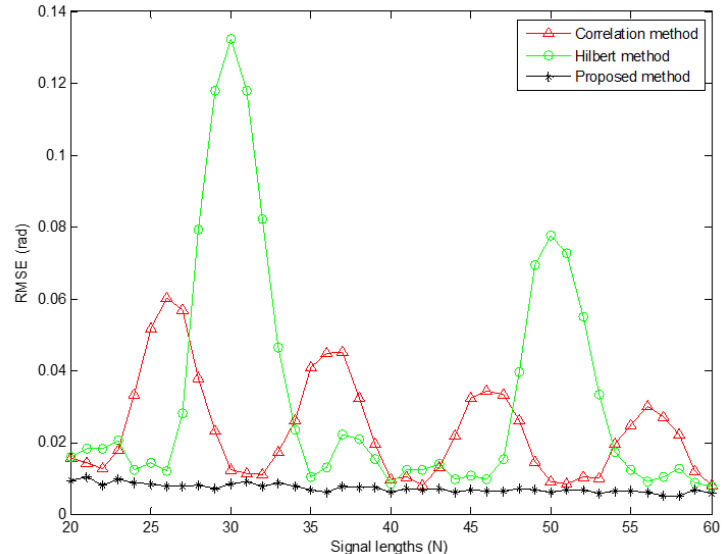
Figure 4. RMSE comparisons with different correlation lengths.